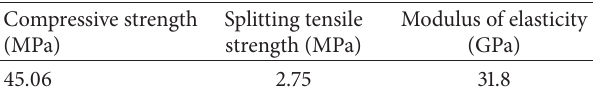
Table 2: Mechanical properties of concrete after 28 days of curing.